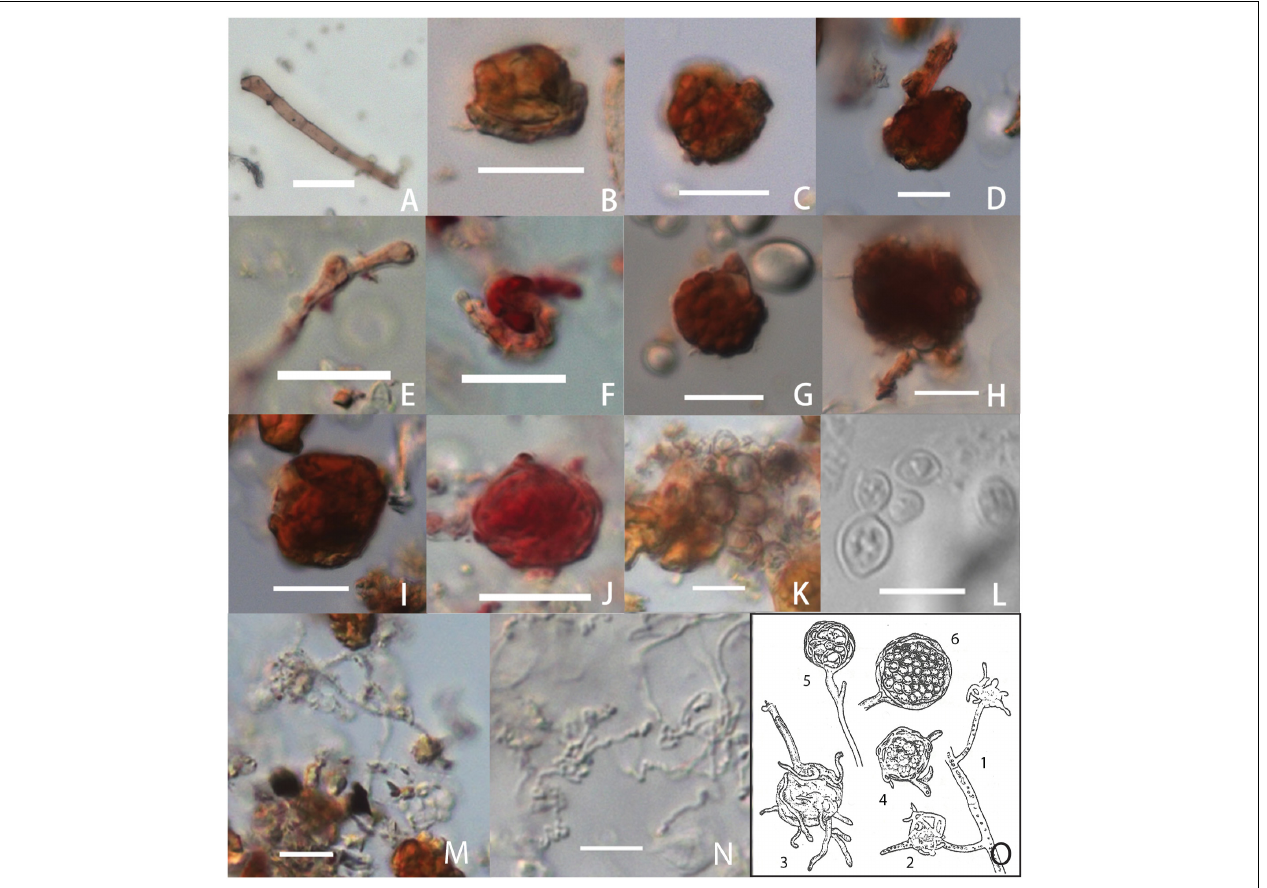
FIGURE 6 | Fungi from Erlitou pottery vessels (A–D,I,K,M) compared to modern reference (E–H,J,L,N,O) . Erlitou fungi: (A) Septate hyphae, with protruding part on the left, an indication of reproduction; (B) Monascus cleistothecium; (C) Monascus cleistothecium with ascospores; (D) Monascus cleistothecium connected to hyphae; (I) Monascus cleistothecium with clear peridial wall cell, asci, and ascospores; (K) clustered yeast cells; (M) mycelia. Modern fungi: (E) Hyphae, with protruding part on the right, an indication of reproduction; (F) hyphae surrounding the Monascus ascogonium, in the formation process of cleistothecium; (G) Monascus cleistothecium with ascospores; (H) Monascus cleistothecium connected to hyphae; (J) Monascus cleistothecium with clear peridial wall, asci, and ascospores; (L) S. cerevisiae yeast cells; (N) Monascus mycelia; (O) Monascus in various development states (1–3: Ascogenous cleistothecia; 4.5: Immature cleistothecia; 6: Mature cleistothecium; after Bao and Zhou, 2007; Figures 4–6 ) (Scales, K–N : 10 µ m; rest: 20 µ